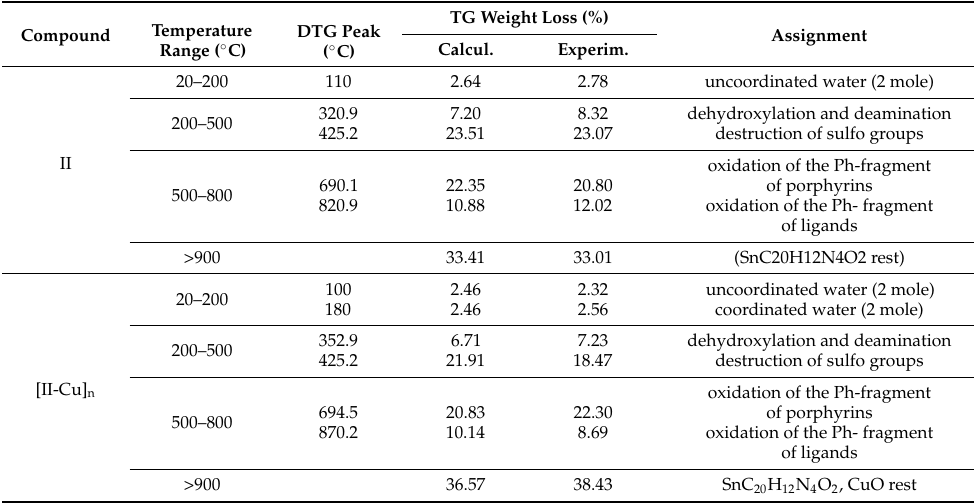
Table 4. UV-Vis spectra of the studied compounds (I, II, Cu-[I-Cu] 6, andCu-[II-Cu] 6 ) . Compounds